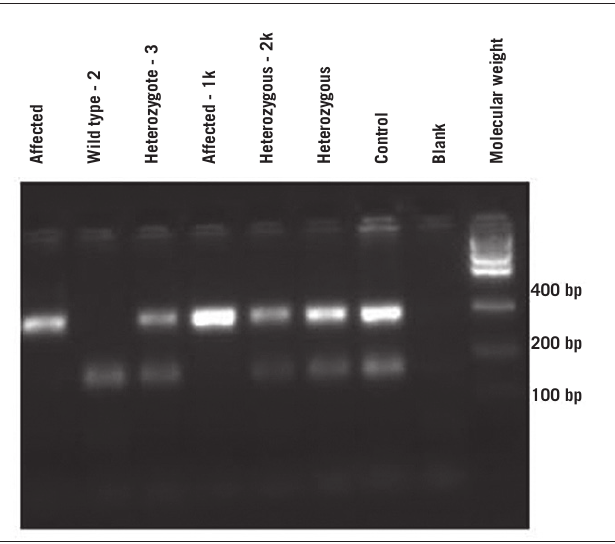
FigurE 4 − Genotyping in mouse tails, for the Large gene